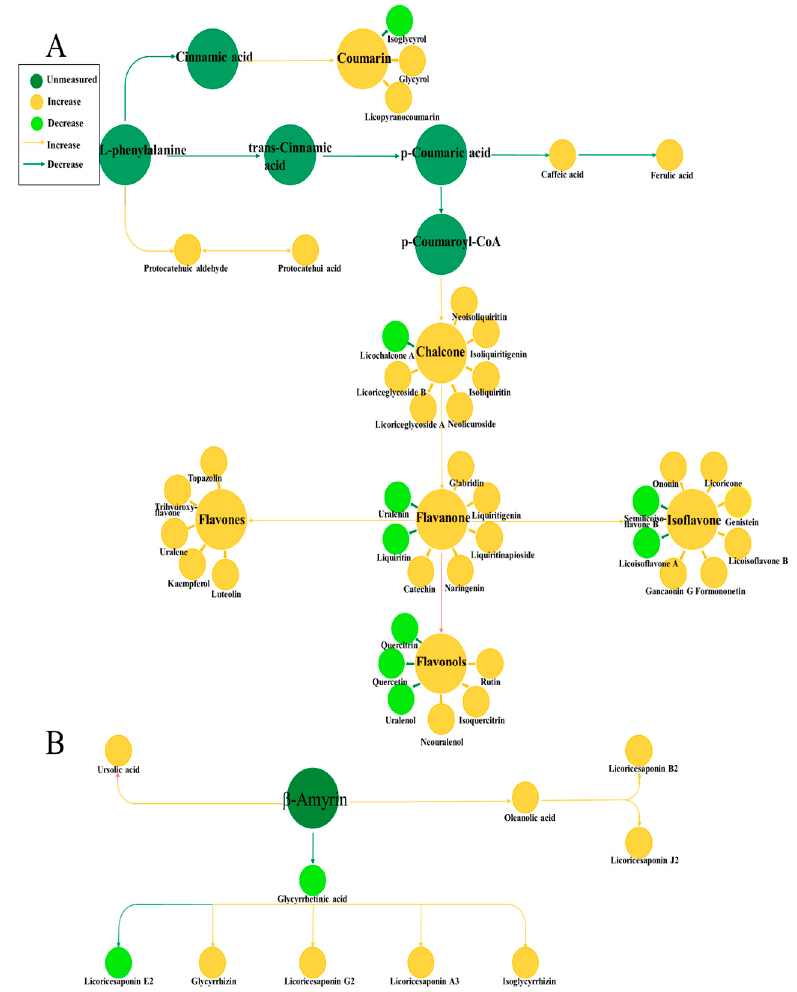
Figure 6. Visualization of secondary metabolite dynamics in a biochemical pathway map. ( A ) represents the pathway map of flavonoids; while ( B ) represents the result of triterpenoids. Dark green circles represent unmeasured components, green circles represent decreased components, and yellow circles represent increased components.